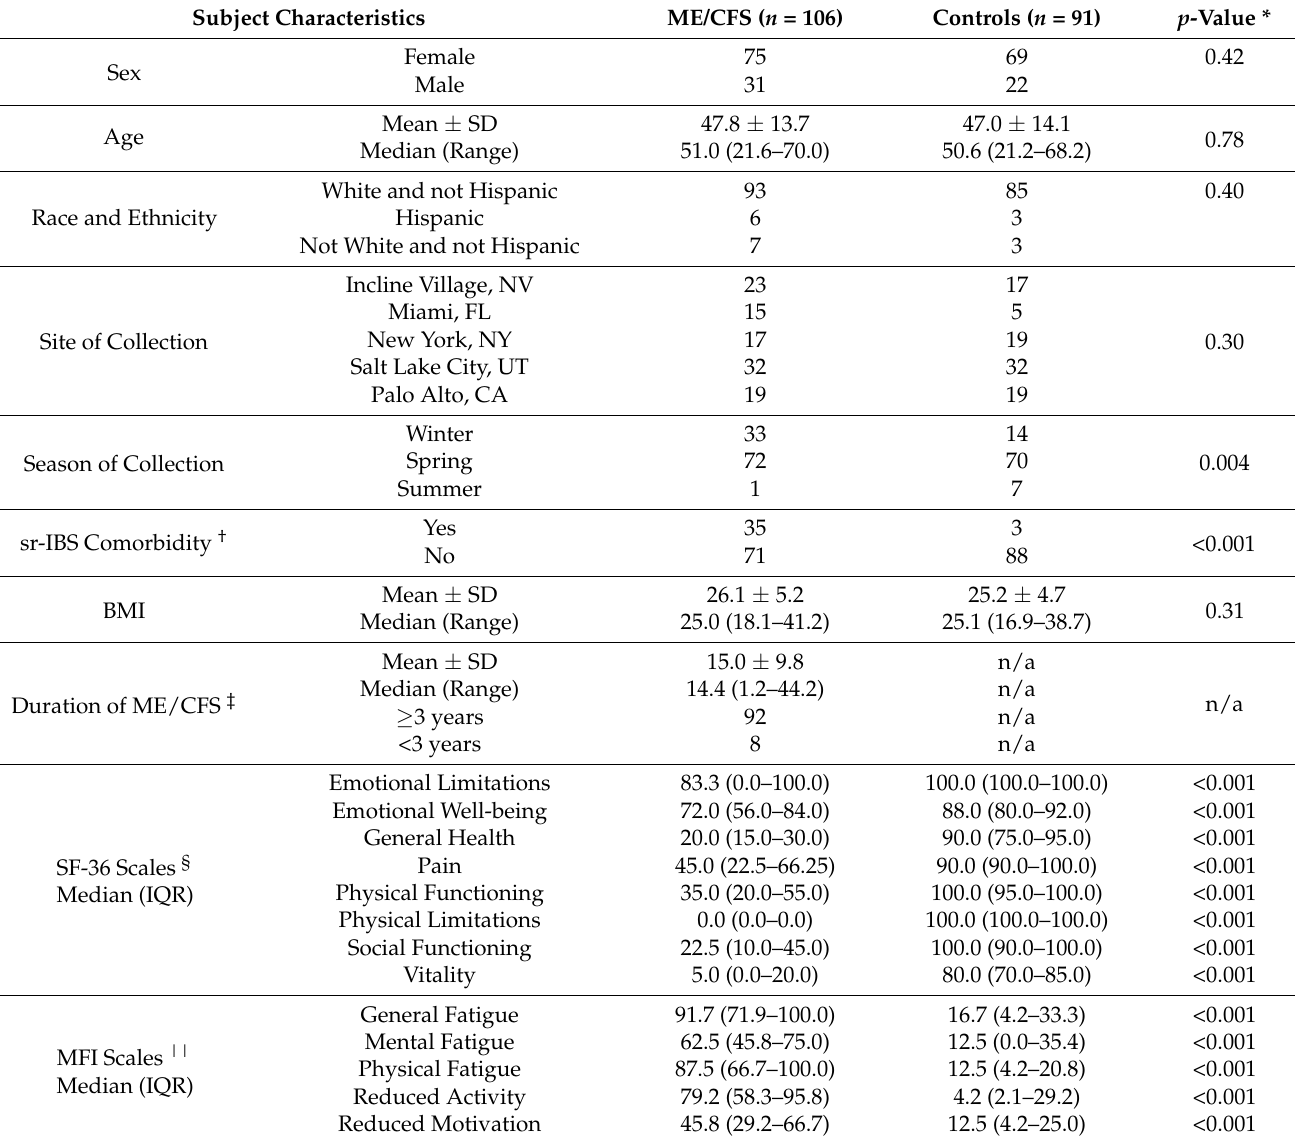
Table 1. Subject